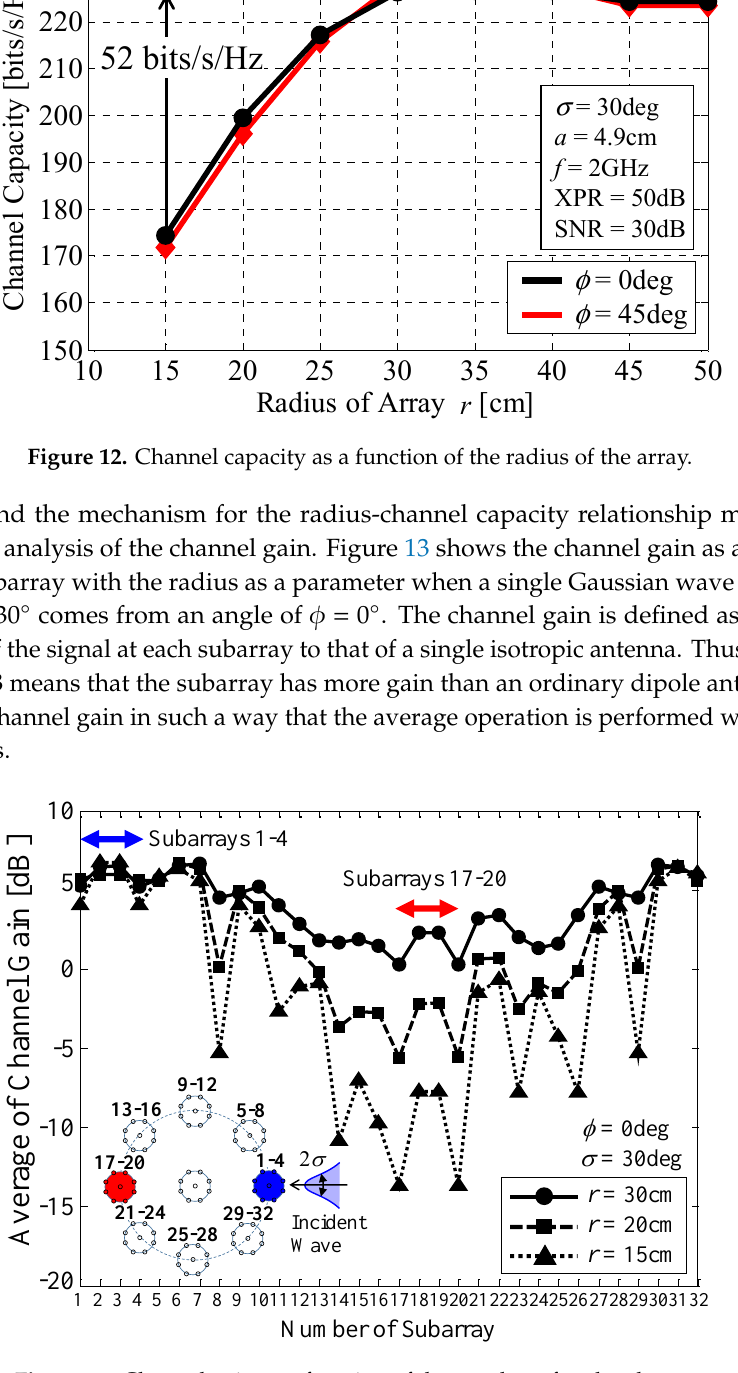
Figure 13. Channel gain as a function of the number of each subarray.